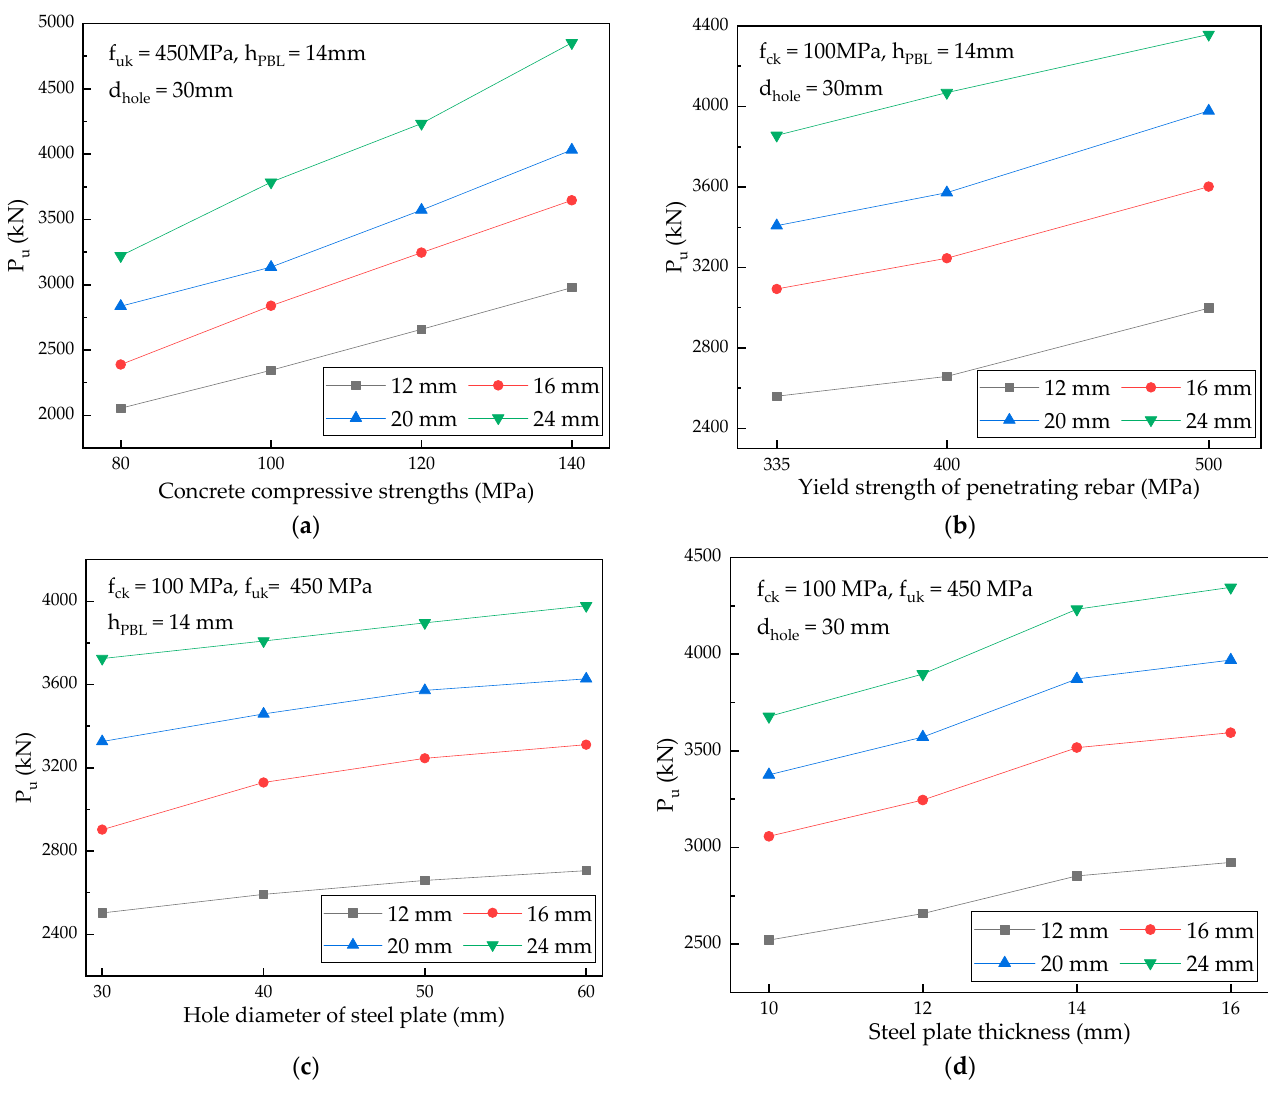
Figure 15. Parameter analyses: ( a ) concrete compressive strengths; ( b ) yield strength of penetrating rebar; ( c ) hole diameter of steel plate; and ( d ) steel plate thickness.